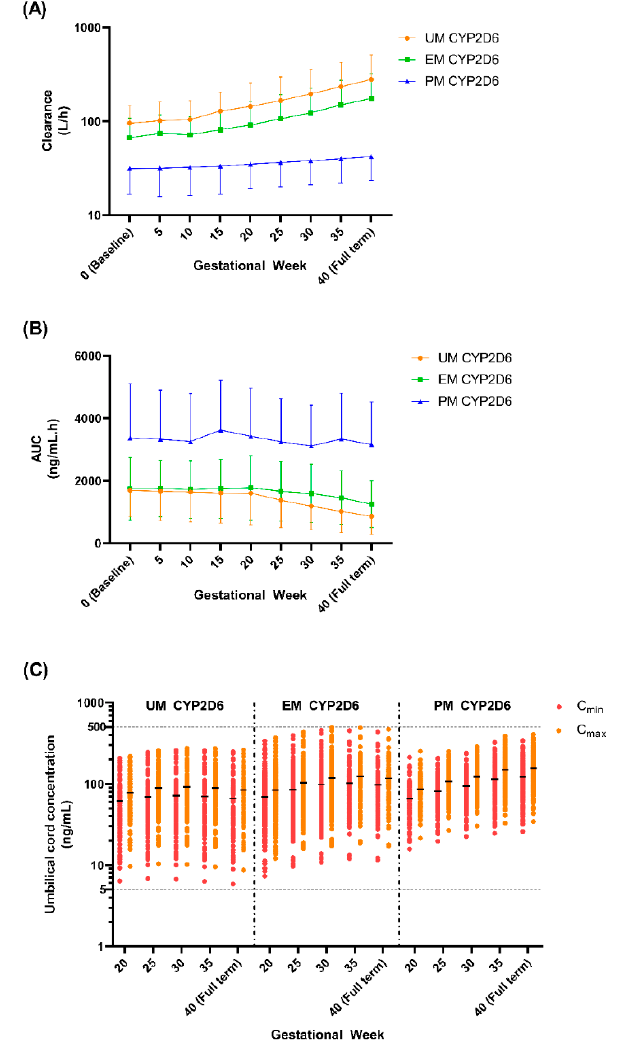
Figure 12. Predicted clearance, area-under-the-curve, and cord concentration based on the recom- mended doses. ( A ) Clearance; ( B ) area-under-the-curve; ( C ) umbilical cord concentration. Top and bottom horizontal lines in ( A , B ) represent standard deviations. Coloured, closed circles in ( C ) are the predicted individual cord concentrations. Horizontal lines on the coloured, solid circles in ( C ) repre- sent the mean. Dashed horizontal lines in ( C ) represent the range of simulated cord concentrations throughout gestational periods and all three CYP2D6 phenotypes (5 ng/mL to 500